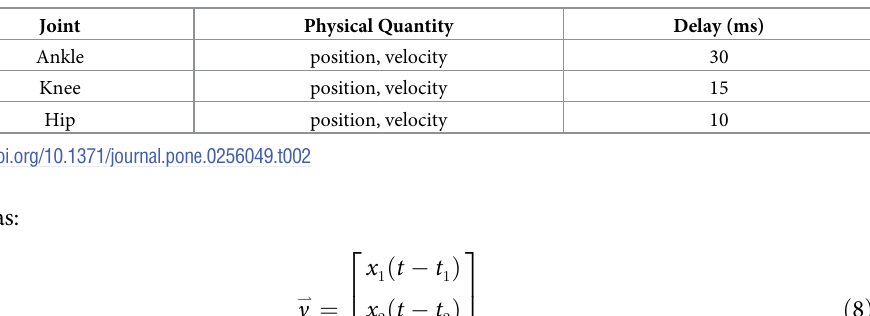
Table 2. Feedback delays at ankle, knee, and hip